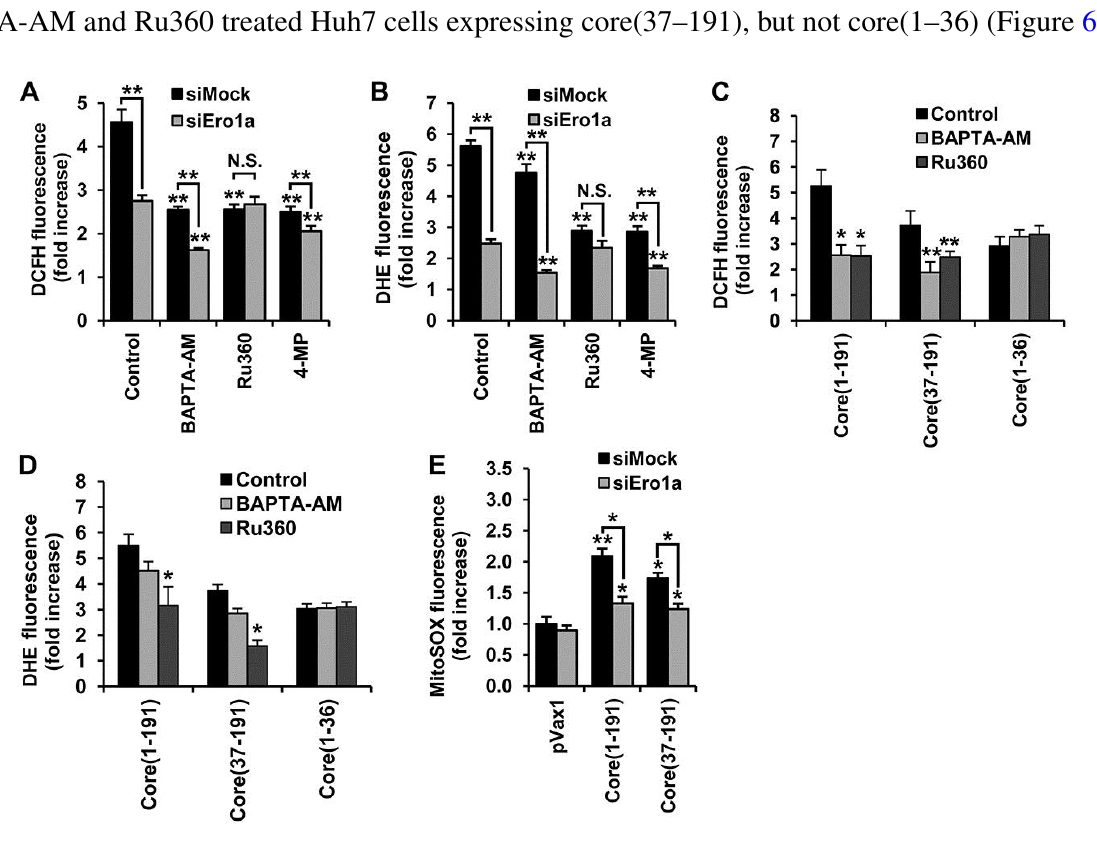
Figure 6. Amino acids 37–191 of the HCV core are responsible for the activation of ER oxidoreductin 1α (Ero1α), redistribution of calcium ions between ER and mitochondria, and the production of superoxide anion and hydrogen peroxide. ( A , B ) DCFH ( A ) or DHE assays ( B ) demonstrate that ROS production by core(1–191) expressing Huh7 cells with siRNA-silenced Ero1α expression is partially inhibited by calcium chelator BAPTA-AM and by CYP2E1 inhibitor 4-methylpyrazole (4-MP), but not by the inhibitor of mitochondrial calcium uniporter Ru360; ( C , D ) The inhibitory effect of calcium chelator BAPTA-AM on the total ROS production in DCFH ( C ), and superoxide anion in the DHE assay ( D ), is mediated on Huh7 cells expressing core(1–191) and core(37–191), but not core(1–36); ( E ) Suppression of Ero1α expression with siRNA in cells expressing core(1–191) or core(37–191) results in a partial decrease in the production of superoxide anion in mitochondria; results of the MitoSOX assay. Huh7 cells transfected with the empty vector pVax1 or a plasmid encoding HCV NS5B served as negative controls. Fluorescence was expressed as a fold-increase compared to the fluorescence measured in mock-treated Huh7 cells transfected with the empty vector pVax1. For experimental details, see Materials and Methods. All data represent the means ± S.D. from triplicate measurements done in three independent experiments. * p < 0.01; ** p < 0.001. N.S., not significant.